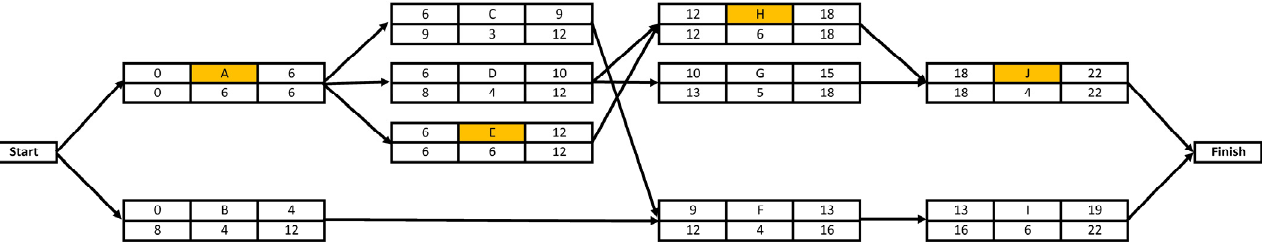
Figure 7. CPM diagram of the project under study.